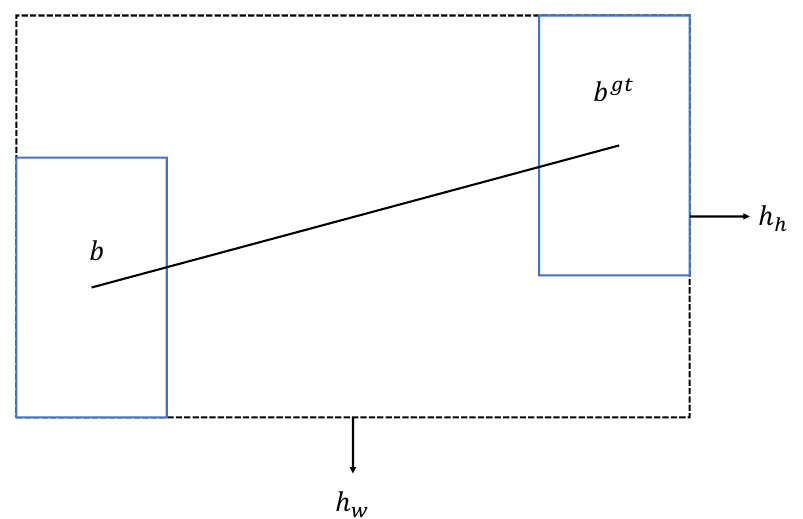
Figure 11. The process of redefining the distance